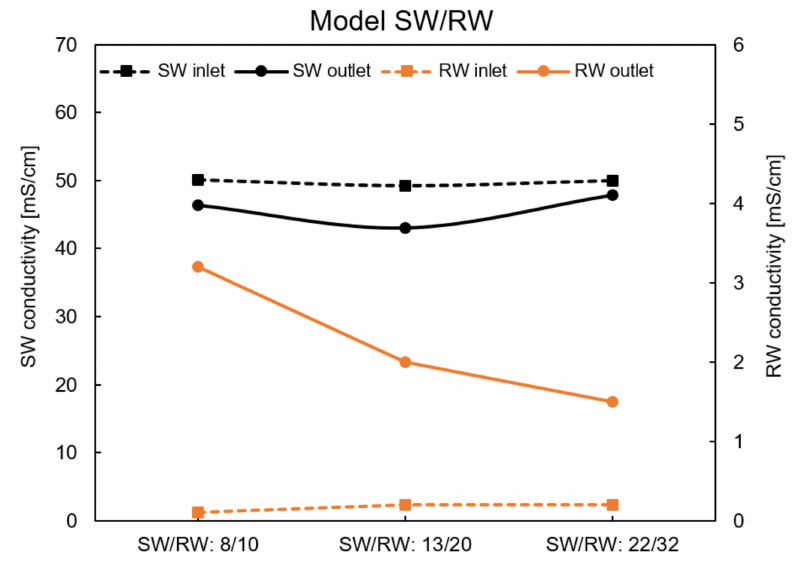
Figure A4. Conductivity of inlet and outlet solutions using the natural RO brine/RW at zero current. The actual OCV of all RED tests using natural and model feed solutions at different flow rates are shown in Figures A5–A8. Generally, the OCVs showed increasing behavior by increasing the feed flow rate, as discussed.